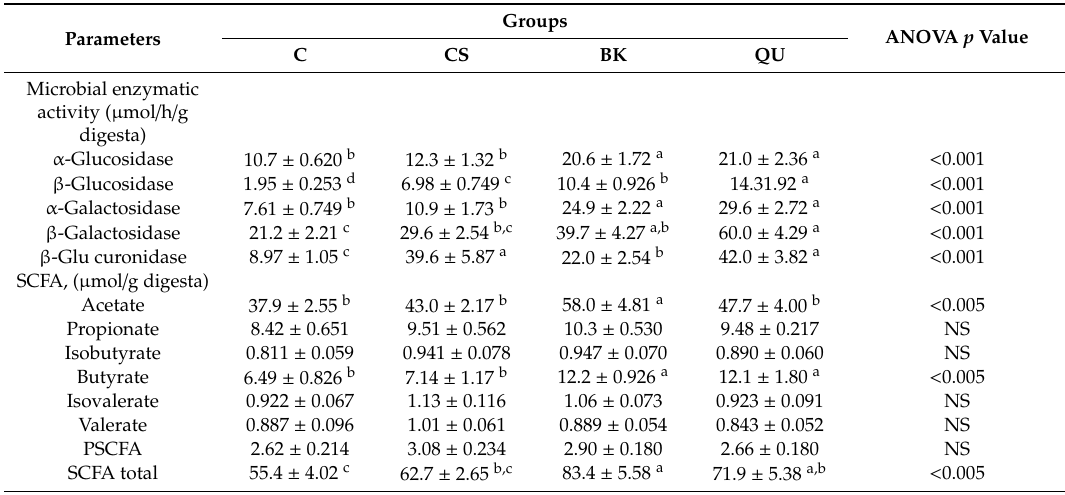
Table 4. Activity of microbial enzymes and the short-chain fatty-acid (SCFA) content in the caecum digesta of rats fed experimental diets.